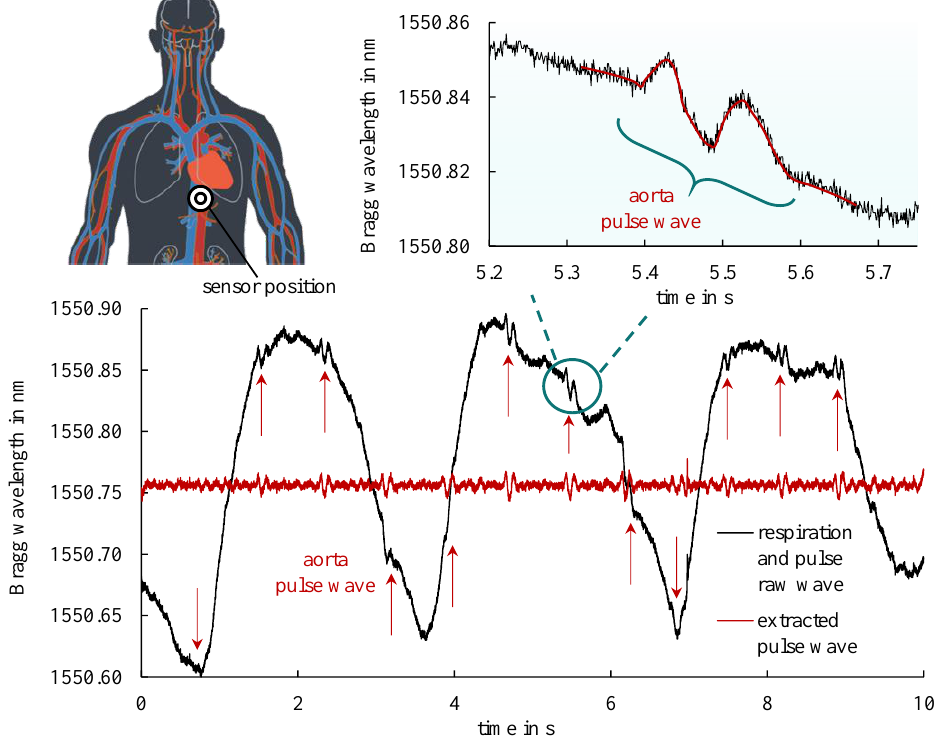
Figure 7. Sensor pad applied to the aorta region for simultaneous vital sign monitoring of respiration and pulse waves (draft of circulatory system based on [30]). The inset clearly indicates a superimposed pulse signal wave which is readily extracted by high pass filtering (red curve).